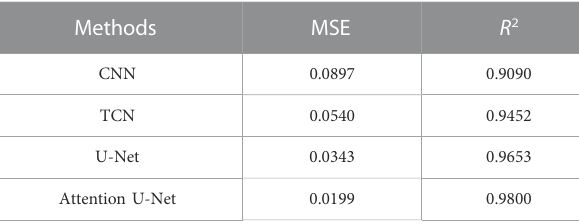
TABLE 1 MSE, R 2 between inversion results and actual acoustic